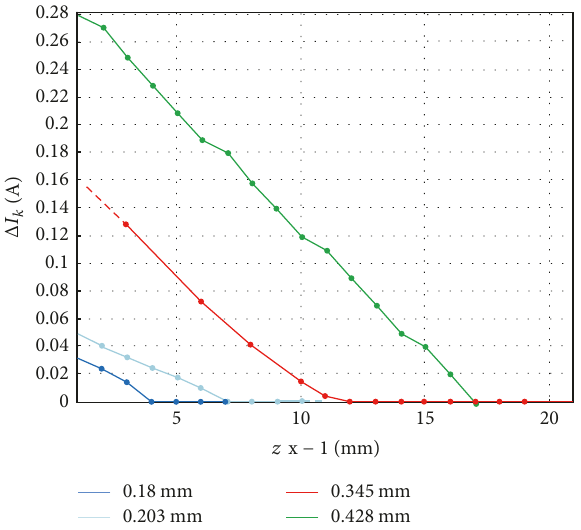
Figure 5: The secondary current waveform’s response Δ𝐼 𝑘 to changes in the emission in element Δ𝑆 as a function of depth 𝑧 for four penetration channels with varying transverse dimensions.